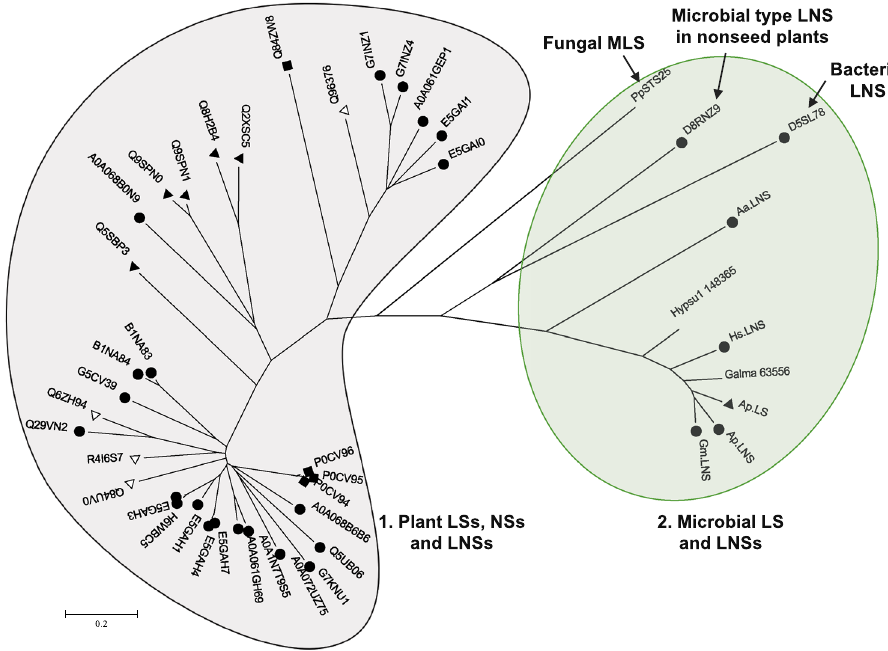
Fig. 5 Phylogenetic tree of LNSs and linalool synthases in plants, fungi, and bacteria. Two major clades, plant and microbial, are clearly segmented. ( R )- linalool synthases are marked with black triangles ( ▲ ), ( S )-linalool synthases with white triangles ( △ ), LNSs with black circles ( ● ), and nerolidol synthases with black rectangles ( ■ ). PpSTS25 is a myrcene/linalool synthase from Postia placenta 20 . For plant and bacterial enzymes, UniProt accession number are used. D8RNZ9, more similar to the bacterial LNS than plant ones, was a LNS isolated from the nonseed plant Selaginella moellendorf fi i (Spikemoss). Details of all the enzymes are in Supplementary Table